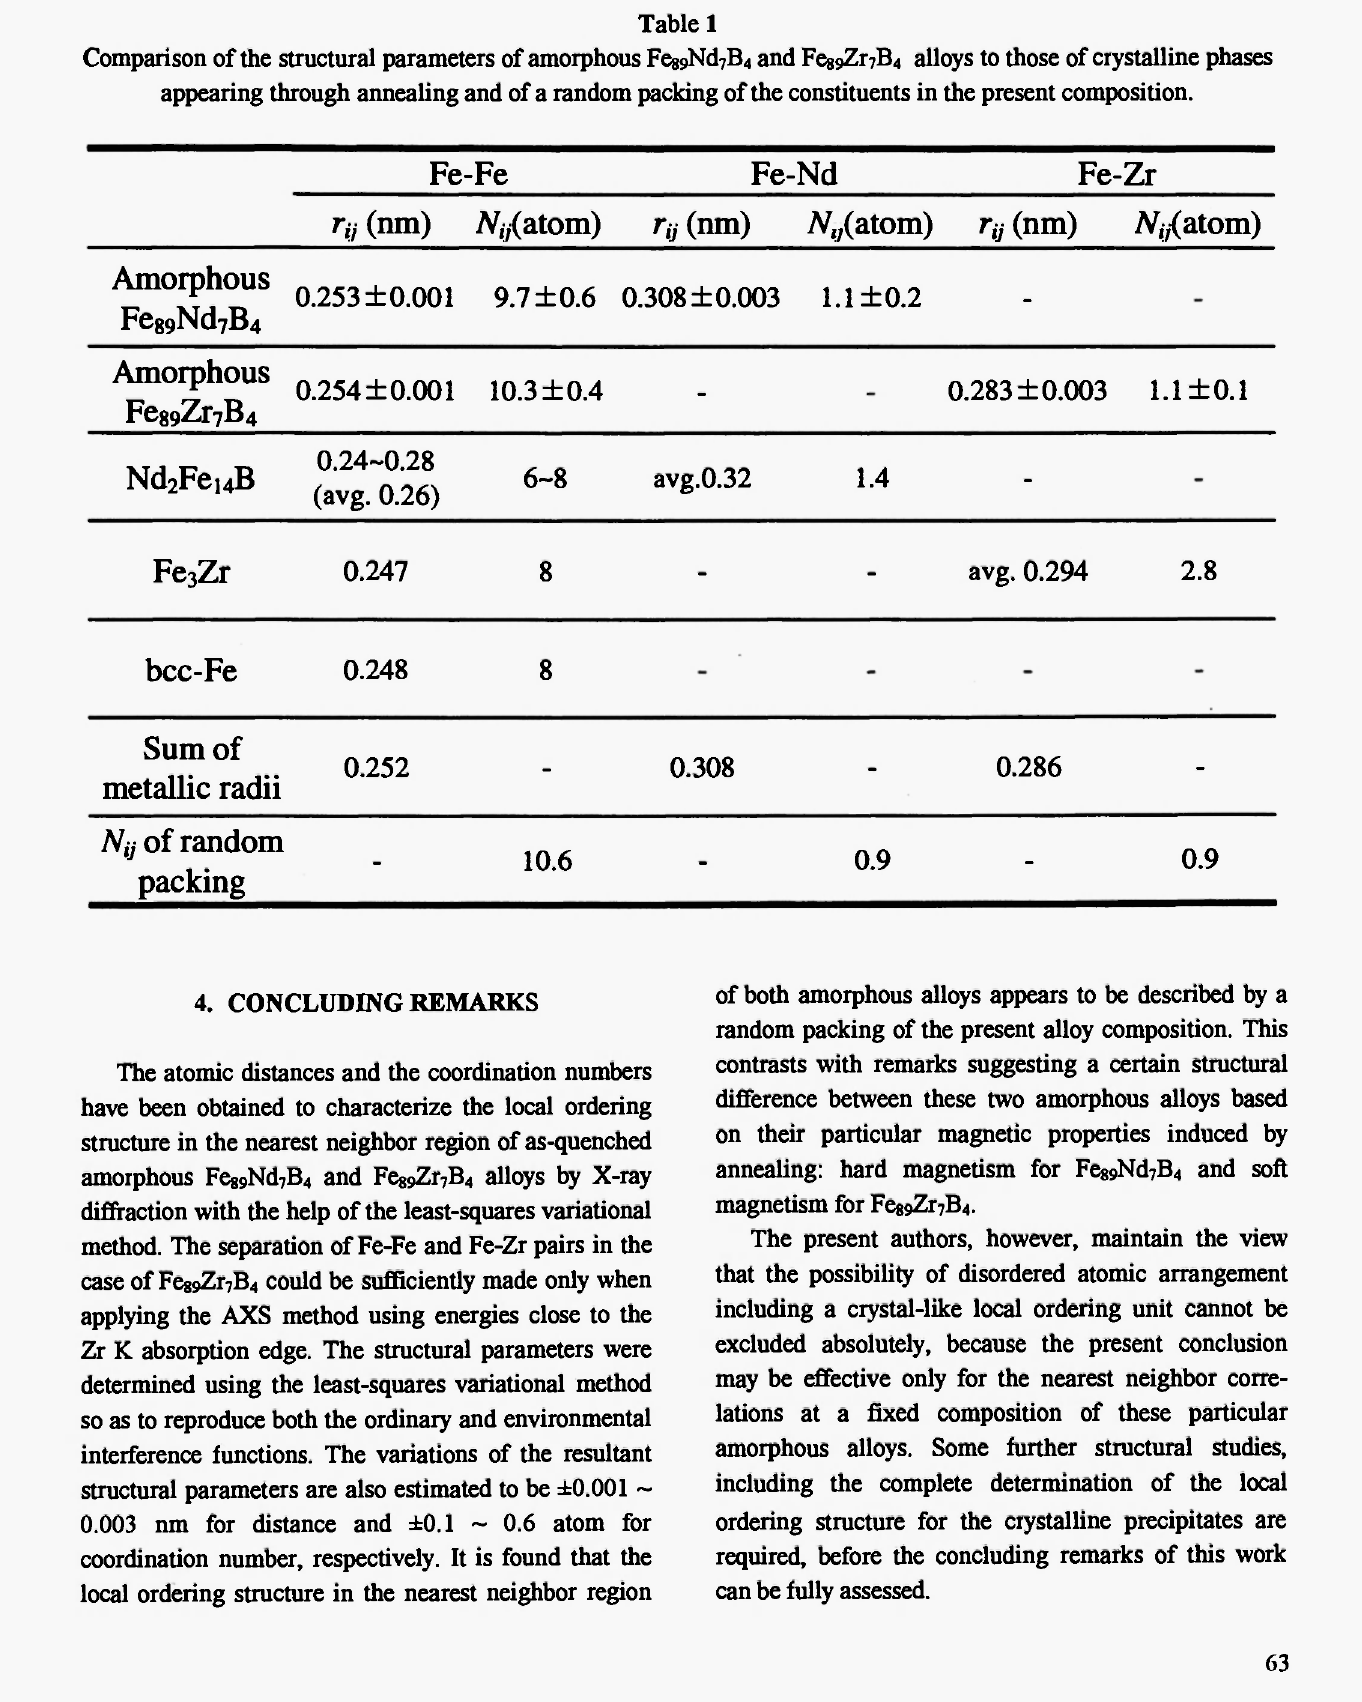
B and Fe89Zr B alloys to those of crystalline phases 7 4 7 4